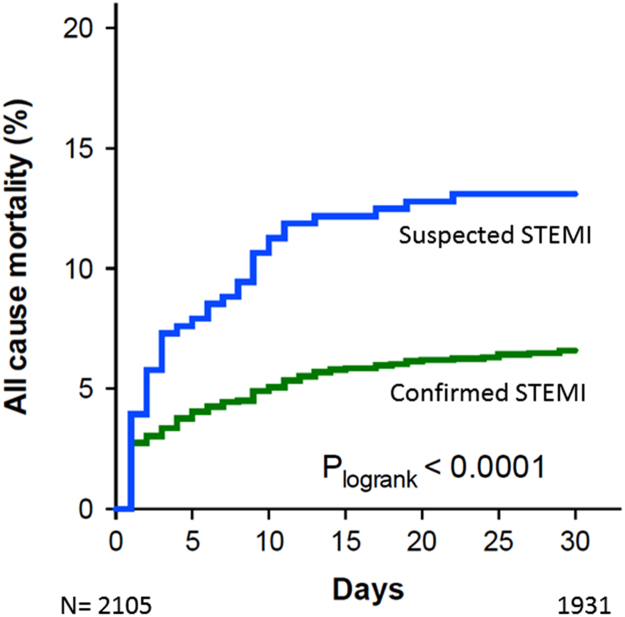
Survival in patients with suspected STEMI where the diagnosis was confirmed (blue) and where STEMI diagnosis was rejected.